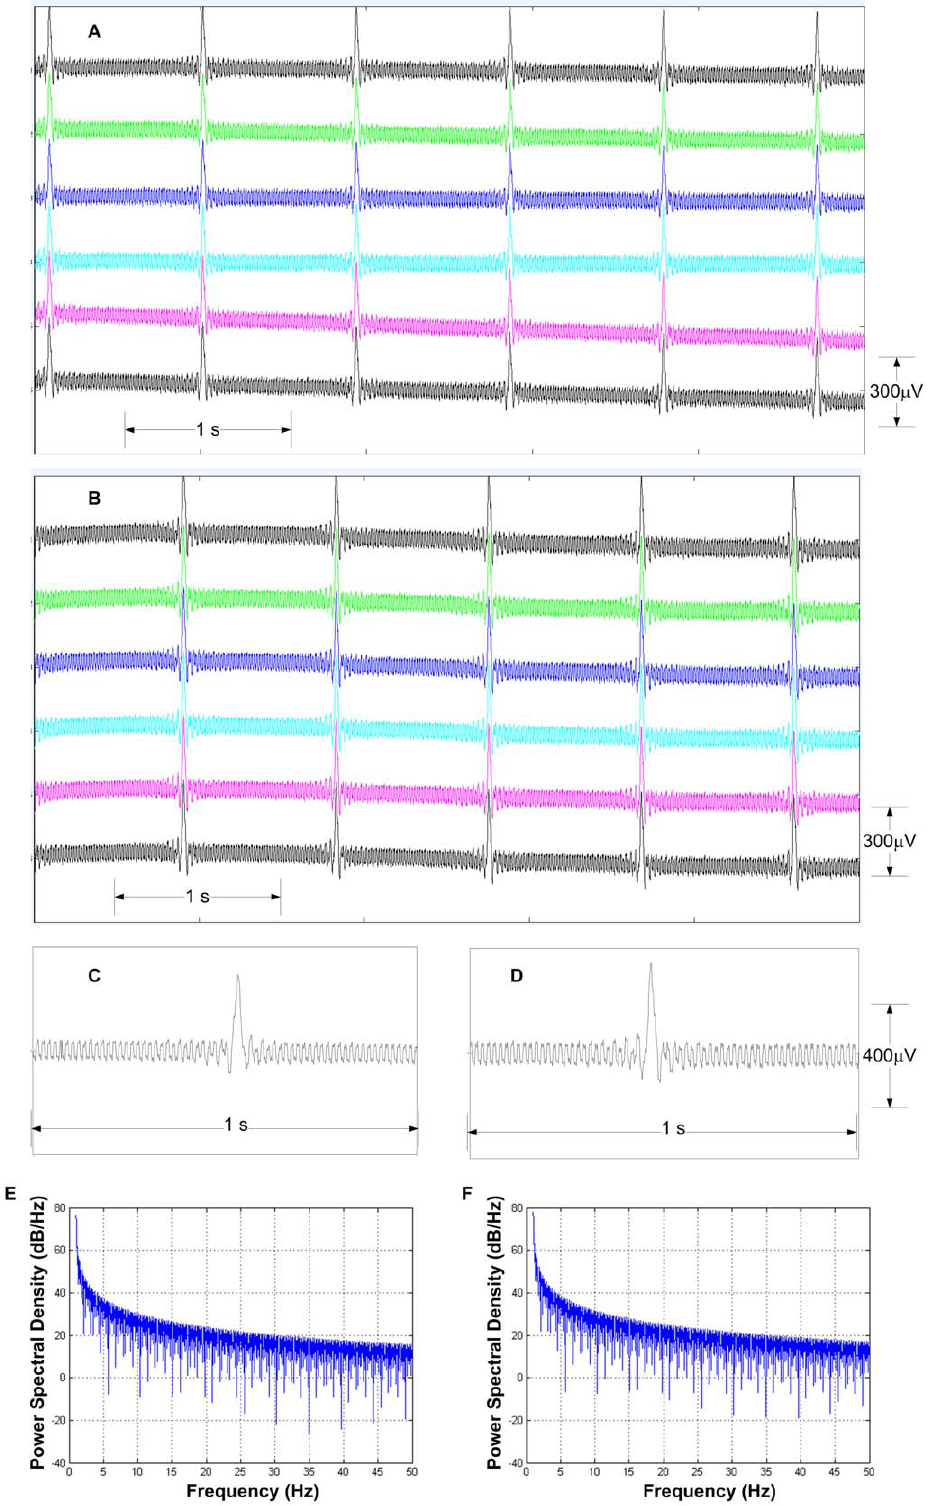
Figure 7. Recordings studies of the PTFOS electrodes set. Comparison between electrical recording of a Sin(x)/x function with amplitude of 300 m V of a stainless steel set ( A and expanded in C ) and the PTFOS ( B and expanded in D ). Comparison between power density spectrum (PSD) of silent (only noise) recording of a stainless steel set ( E ) and the PTFOS ( F ).